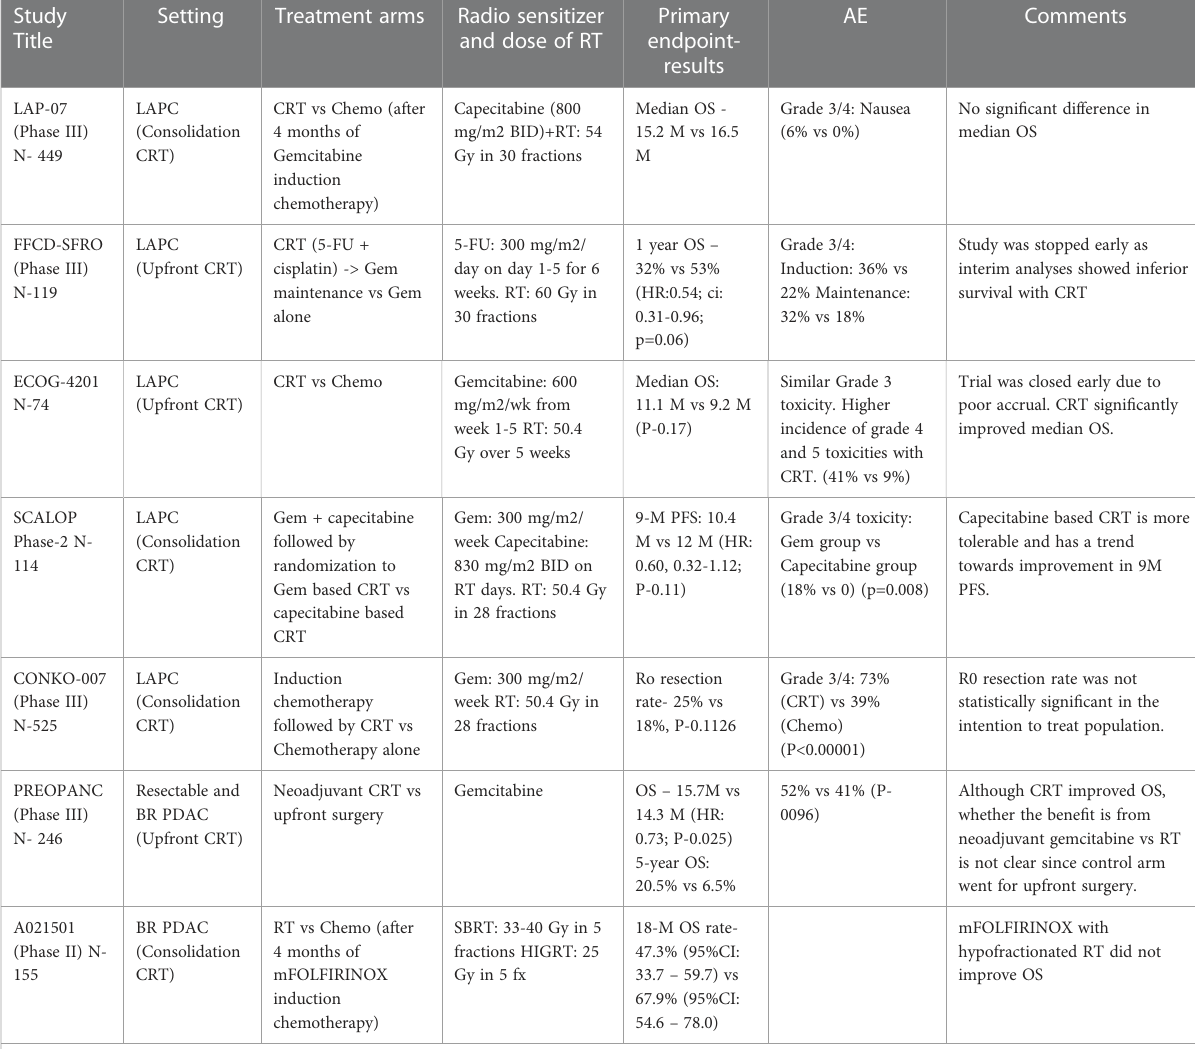
TABLE 1 List of prospective randomized trials that evaluated the effect of CRT on survival outcomes and adverse effect pro fi le in locally advanced and borderline resectable PDAC (20 –